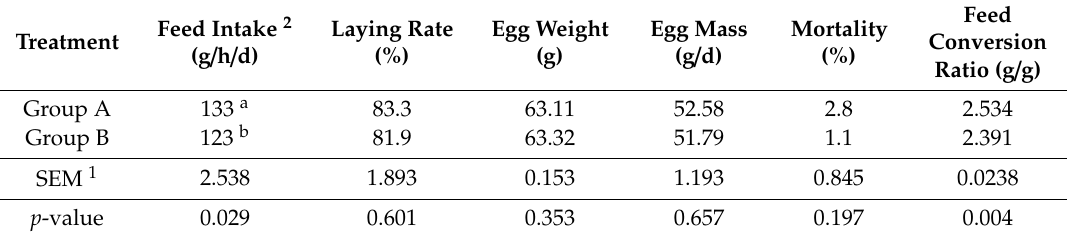
Table 5. Production performance and mortality rate of laying hens fed a commercial diet (Group A) or a soy-free diet + live larvae (Group B) from 67 to 78 weeks of age.